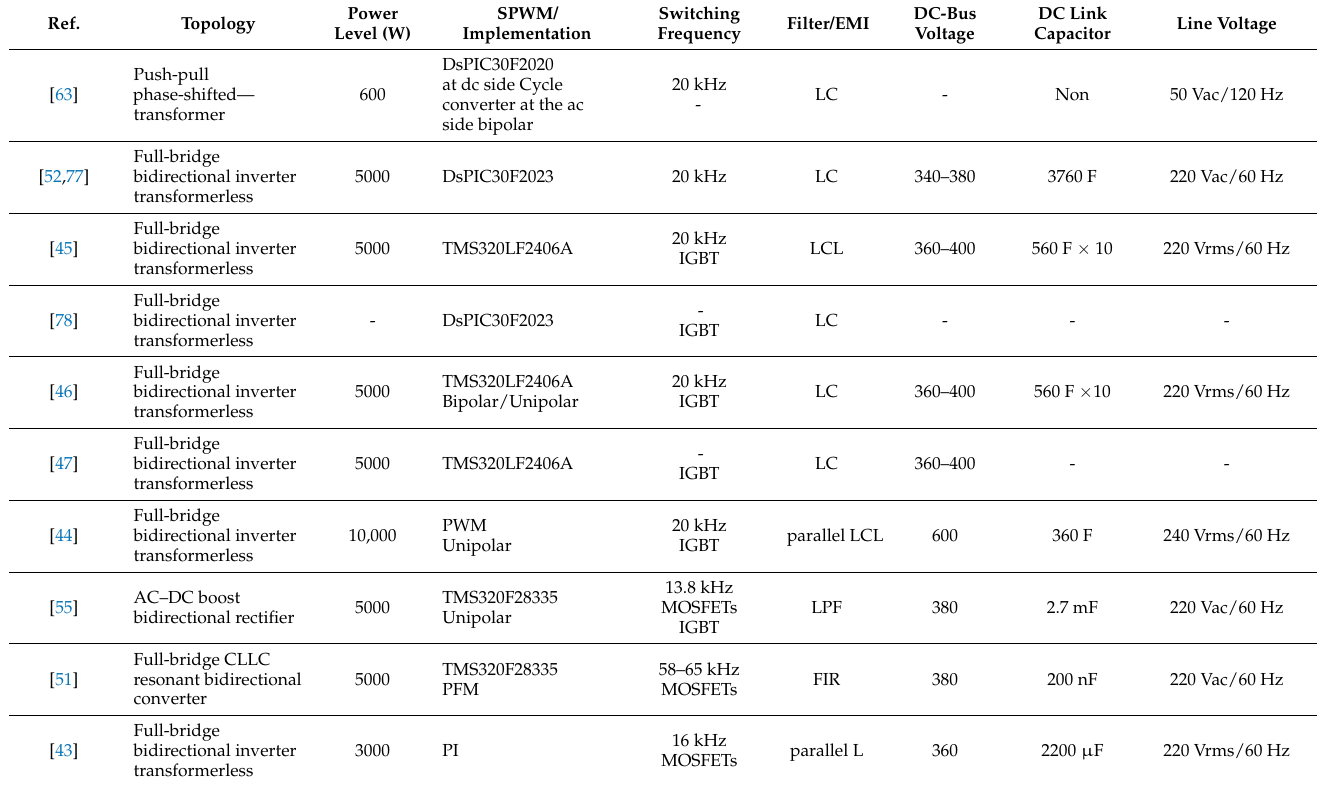
Table 1. Control modulation and passive devices of transformer and transformerless bidirectional topologies for DC distribution